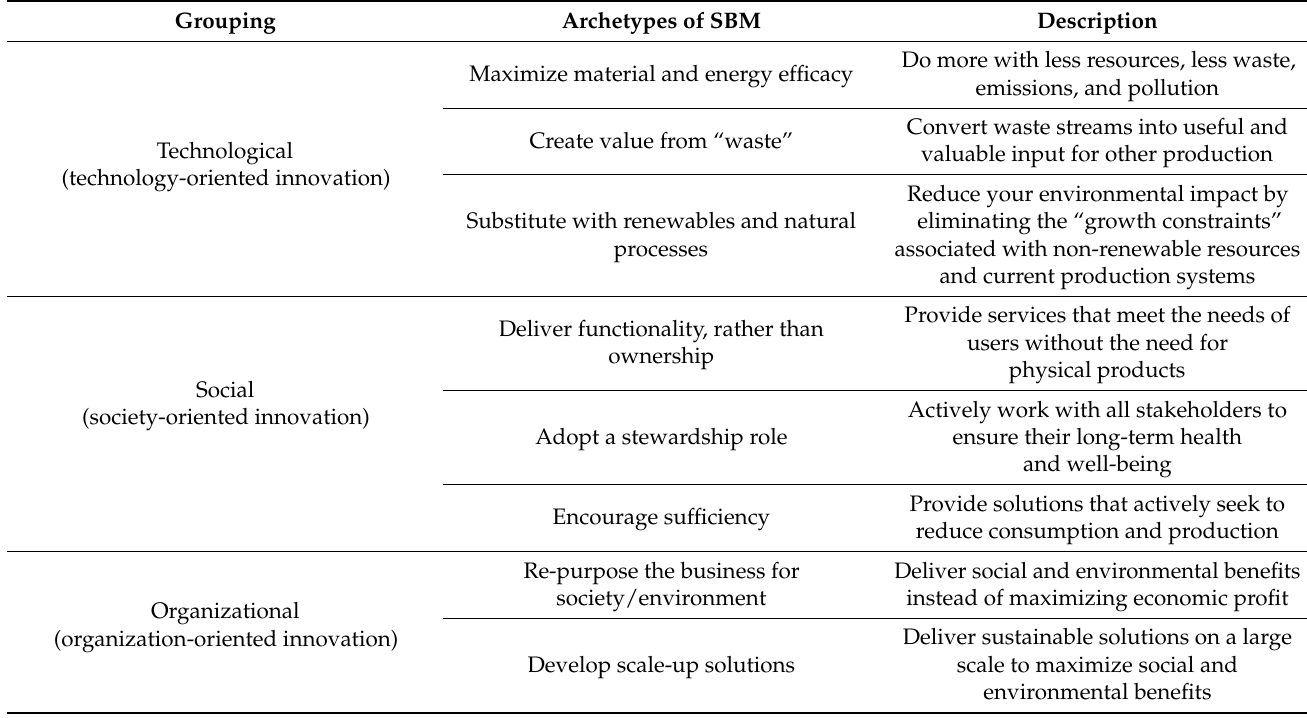
Table 2. Archetypes of